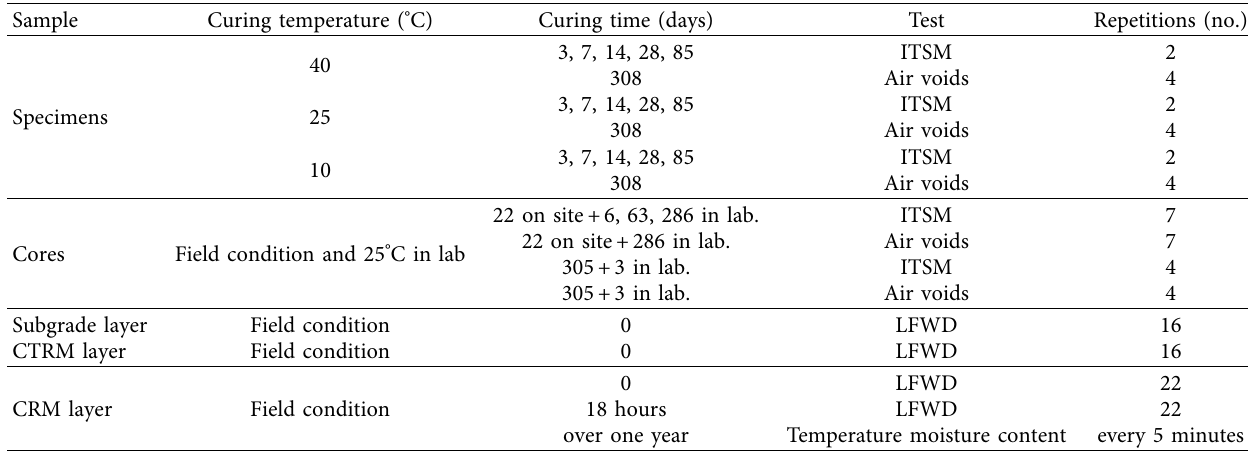
Figure 10: Installation of the sensors: (a) positioning of steel bars and wooden tablets; (b) tablets and steel bar after compaction; (c) installation of the sensors; (d) sensor covered by cold recycled mortar; (e) metallic tubes containing the cables sealed with cementitious mortar; (f) data logger installation connection of the sensors. Table 2: Testing